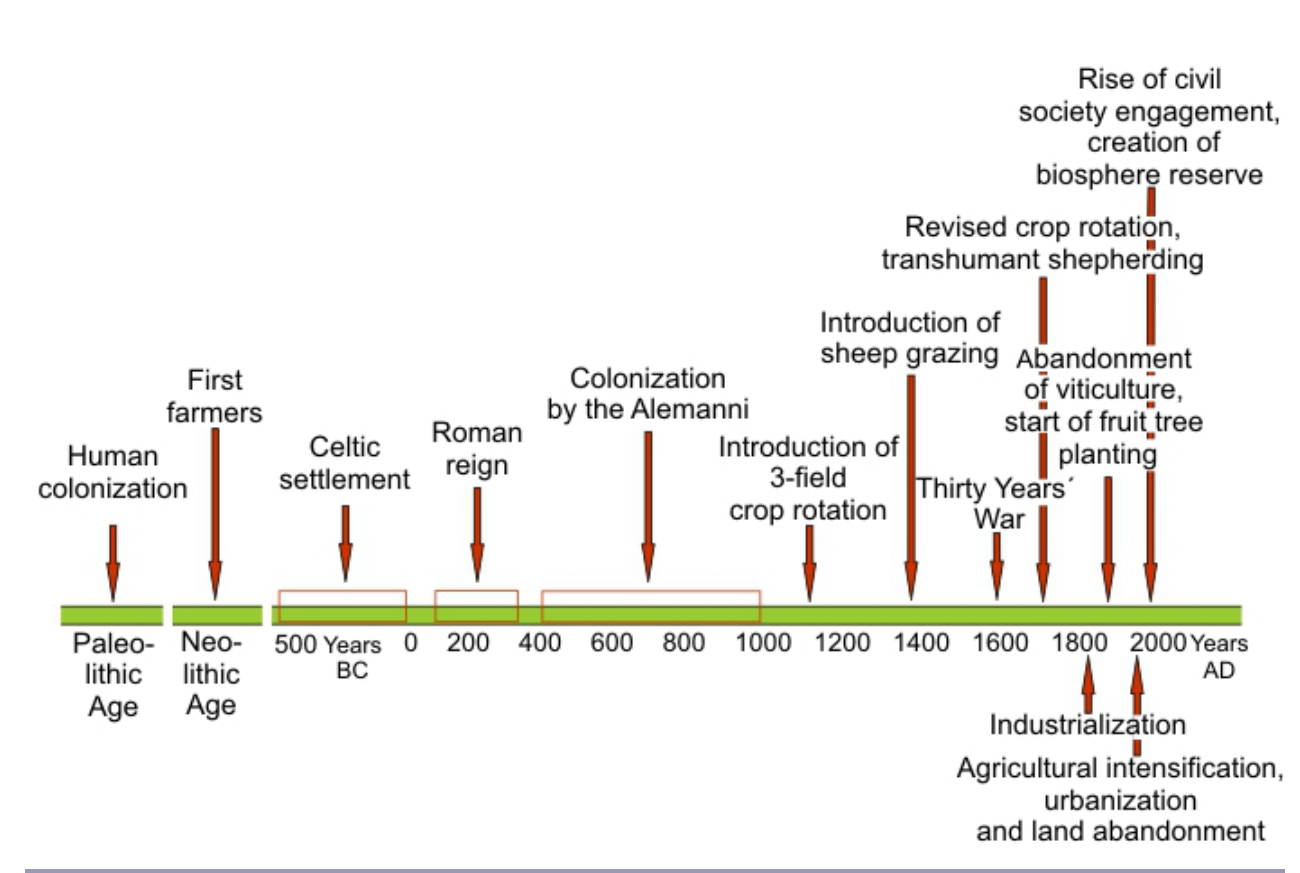
Fig. 2 . Major eras and events in the land-use history of the Swabian